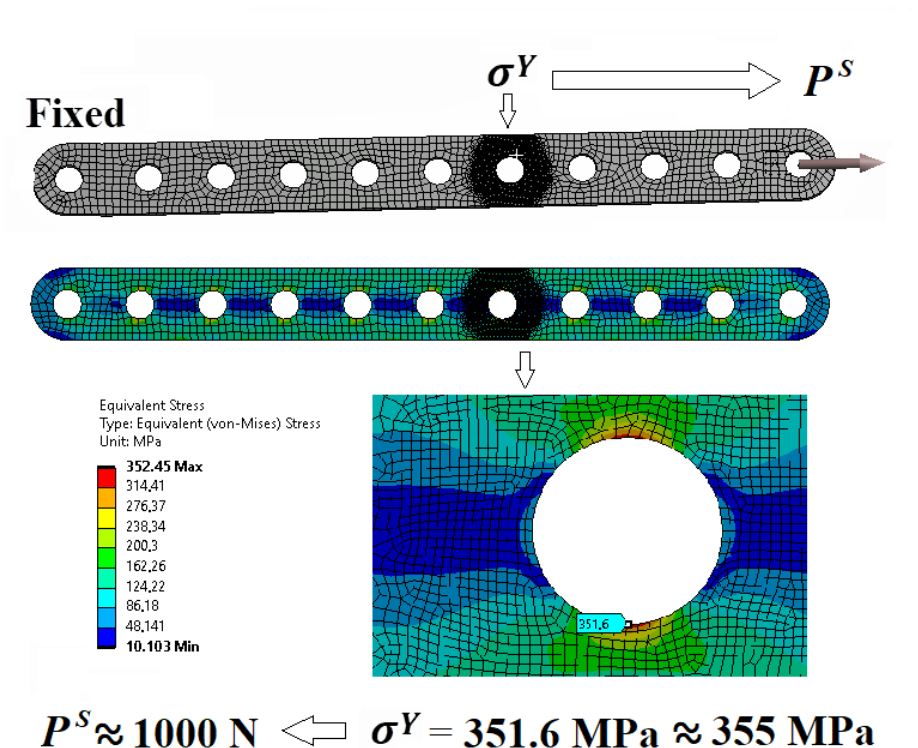
Figure 8. Simulation of the effect of the notch, see Appendix B, Table A2, Label